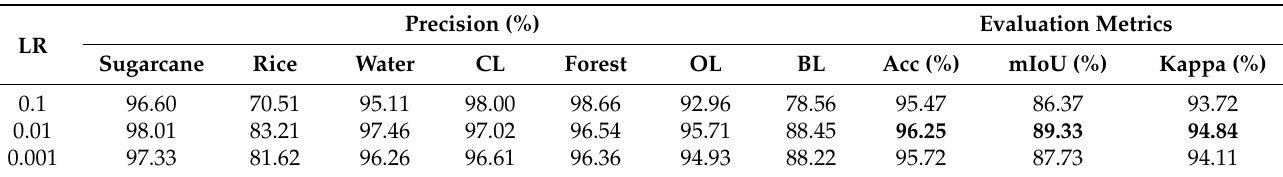
Table 3. Learning rate